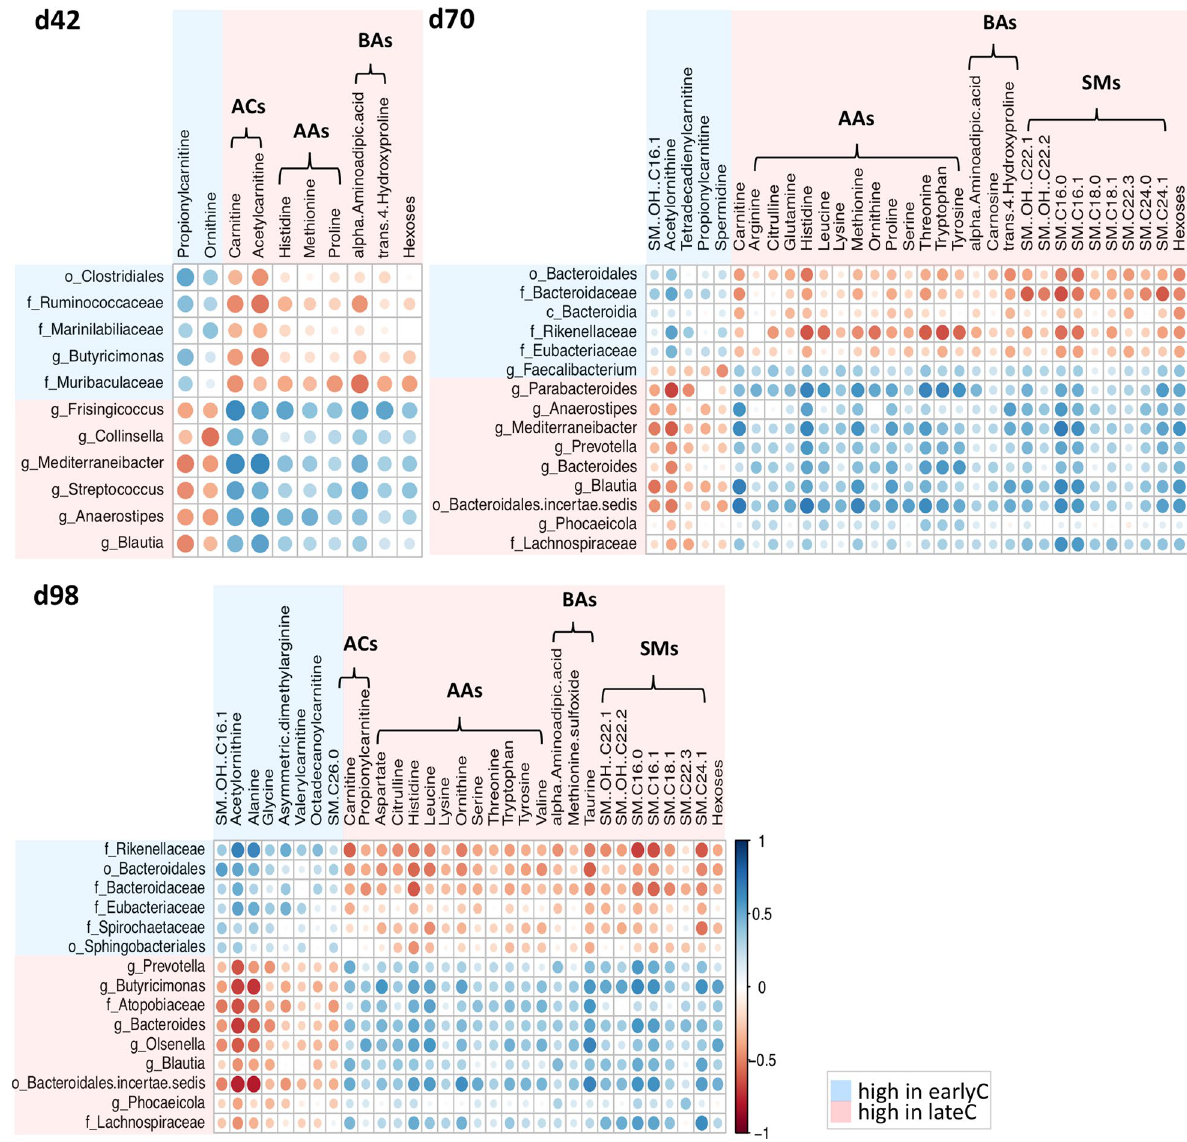
Fig. 7 Heatmaps showing the Spearman’s rank correlations between differentially abundant faecal microbial genera and plasma metabolites of weaning groups. Colours indicates the correlation between microbiome and metabolome (blue: significant positive, red: significant negative, and white: non‑significant). Only Spearman correlation coefficients with p < 0.05 are shown. Abbreviations (ACs, AAs, BAs and SMs) indicates following metabolites classes: acylcarnitines, amino acids, biogenic amines, and sphingomyelins